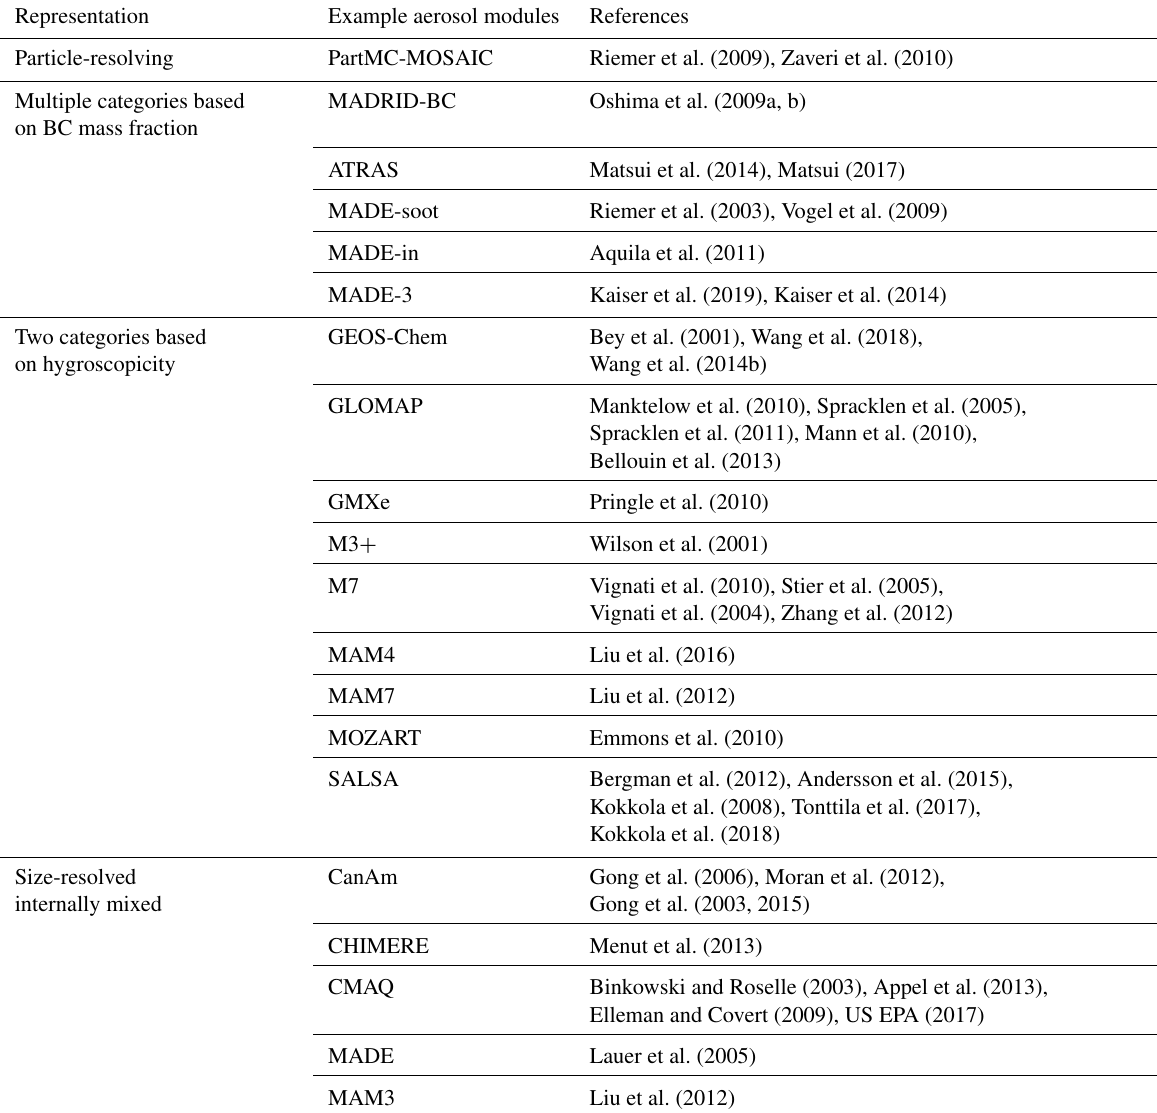
Table 1. Partial list of previous representations of mixing state in aerosol modules, from Stevens and Dastoor (2019). See text for expansion of acronyms, where